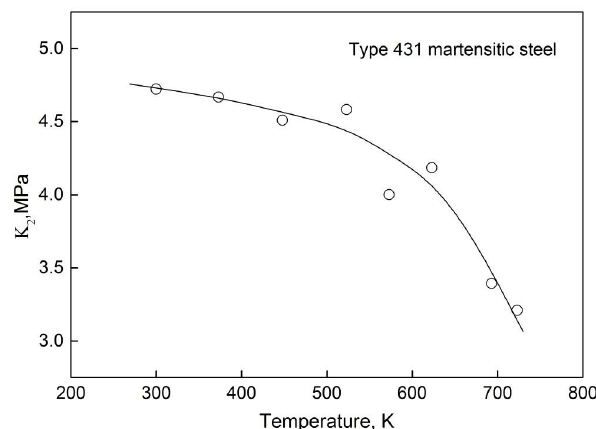
Figure 13: Variation of Ludwigson / Hollomon work hardening pa- rameter K 1 with temperature for the AISI 431 steel.